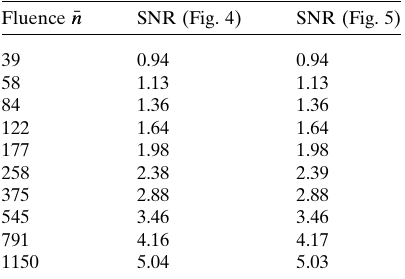
Table 1 Assumed values of fluence (cid:3) nn in photons per pixel used in the tests of Figs. 4 and 5, along with the resulting values of the signal-to-noise ratio (SNR) in projection images. Because of the fluctuations due to different instances of estimated Poisson noise, the SNR values show slight variations between the two